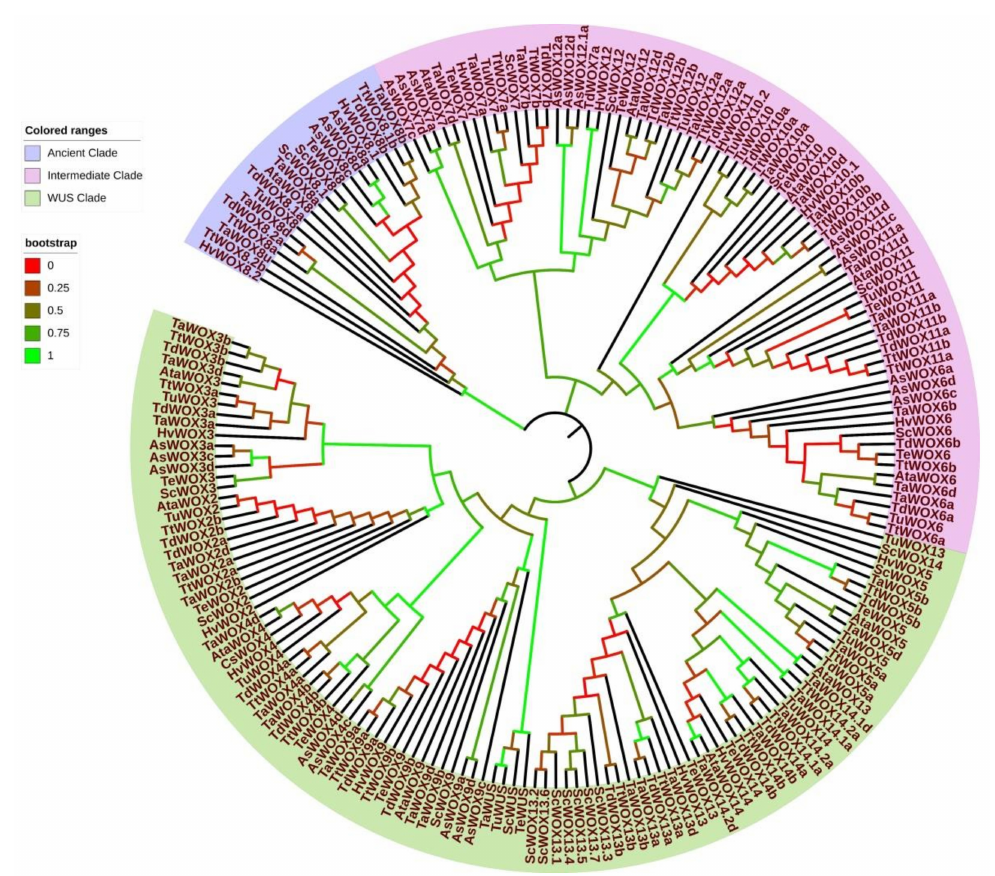
Figure 5. Phylogenetic relationships among WOX proteins from T. aestivum , H. vulgare , T. elongatum, A. sativa , S. cereale , T. dicoccoides, T. turgidum, A. tauschii , and T. urartu. Phylogenetic tree was constructed based on the sequences of WOX proteins in six Triticeae species implemented by the MEGA X software using maximum likelihood method. Legend in upper left displayed colored ranges of WOX